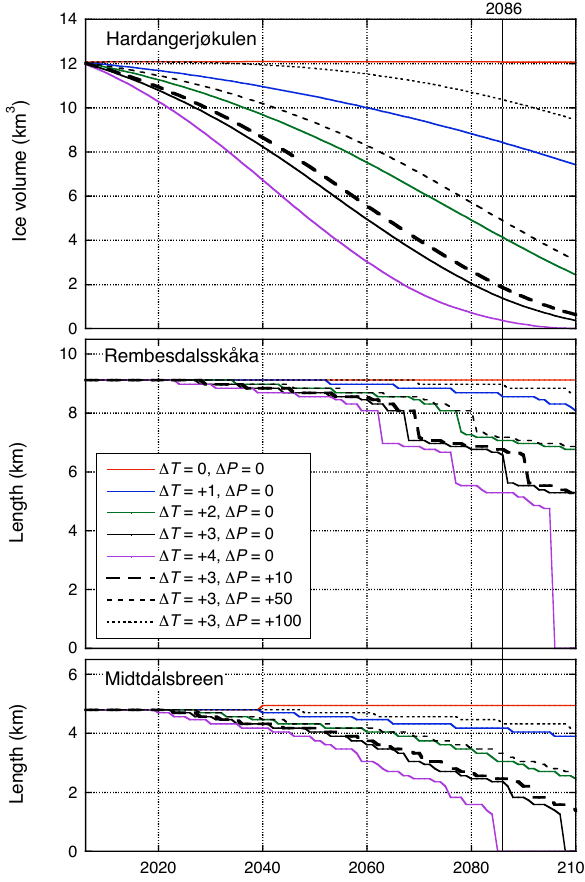
Fig. 11. Ice cap volume and length change for Rembesdalsskåka and Midtdalsbreen from 1905 to 2100 for different climate scenar- ios applied from 2006 onwards. The imposed temperature ( 1T in ◦ C) and precipitation ( 1P in %) changes are constant through the